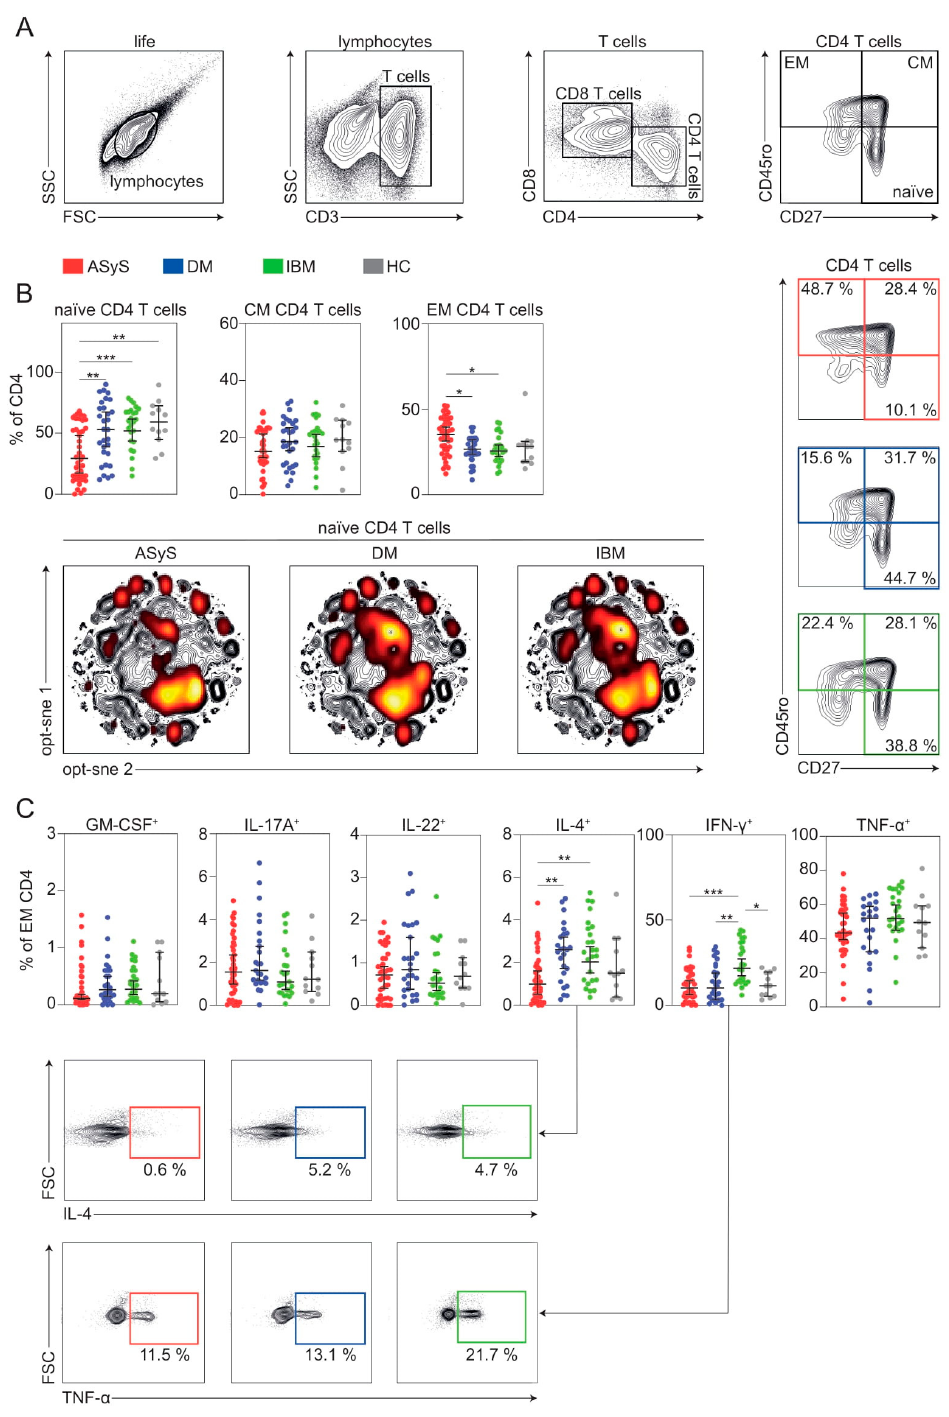
Figure 5. CD4 T cell subsets are distorted in IIM. ( A ) Representative flow cytometry gating strategy for immune cell subsets. ( B ) Frequencies of indicated TEMRA cells and representative flow cytometry (top). Global optimization of tSNE (opt-sne) projection of the CD4 T cell population for all patients concatenated and overlaid. Naïve CD4 T cells are indicated in red in each condition (bottom). ( C ) Representative flow cytometry gating strategy for immune cell subsets. Each point repre- sents an individual ASyS (red), DM (blue), IBM (green) patient or healthy controls (grey). Sig- nificance was determined by Kruskal–Wallis test: * p < 0.05, ** p < 0.01, *** p < 0.001. Abbreviations: ASyS = anti-synthetase syndrome; CM = central memory; DM = dermatomyositis; EM = effector memory; IBM = inclusion body